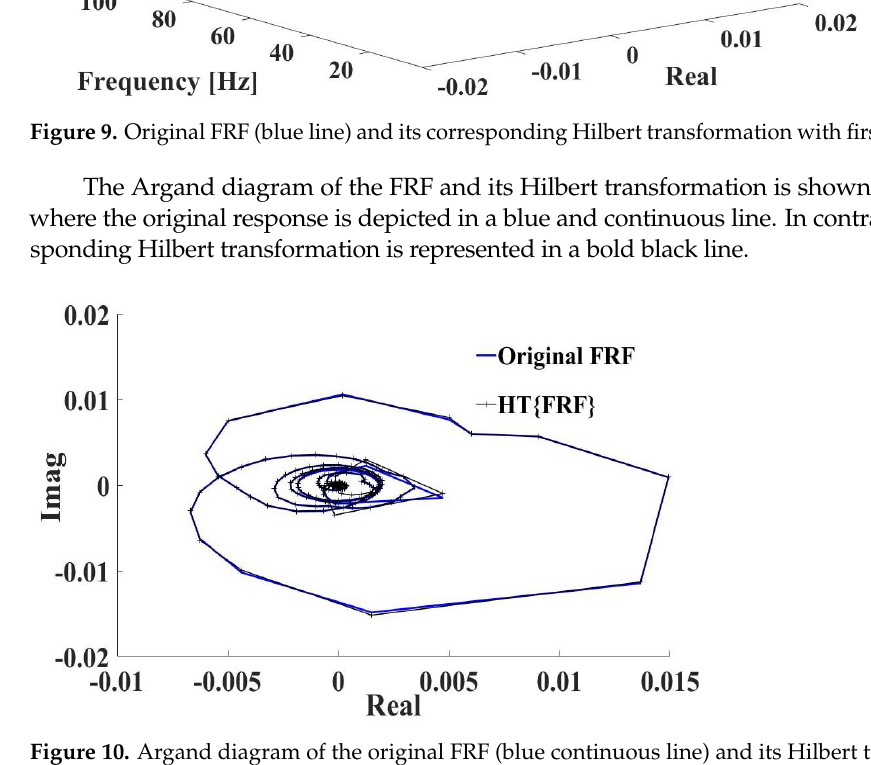
Figure 10. Argand diagram of the original FRF (blue continuous line) and its Hilbert transformation (black marked line).